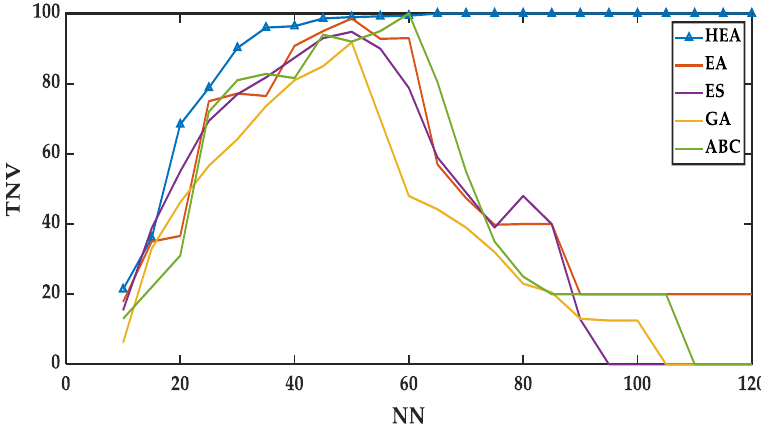
Figure 10. Total Neuron Variation ( TNV ) for different DHNN-RAN k SAT models. Table 10. Tabulated TNV values for different DHNN-RAN k SAT models.